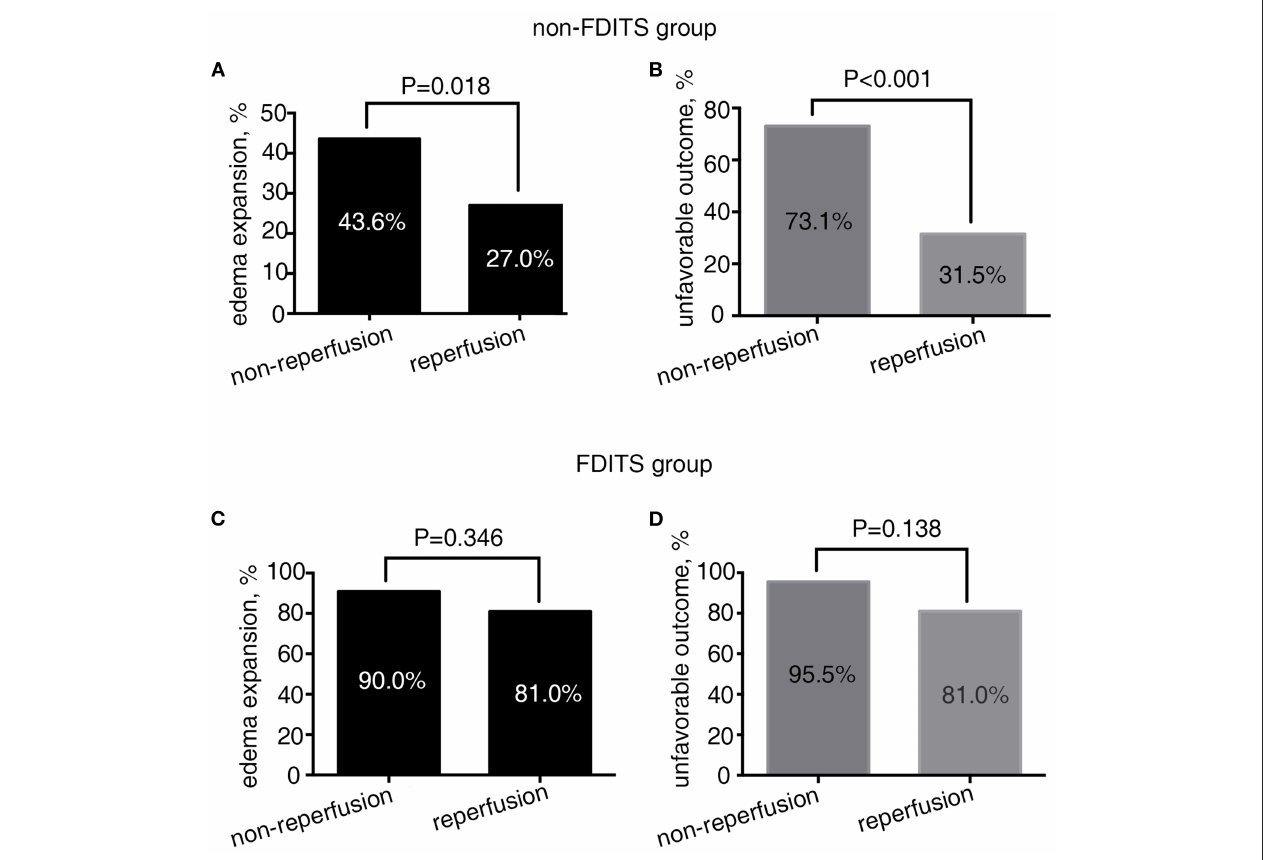
FIGURE 3 | The relationship between reperfusion status and outcome in the FDITS and non-FDITS groups. A non-reperfusion subgroup was more likely to undergo edema expansion (A) and unfavorable outcome (B) than reperfusion subgroup in patients with non-FDITS. While in the FDITS group, no significant difference was found in the rate of edema expansion (C) or unfavorable outcome (D) between two